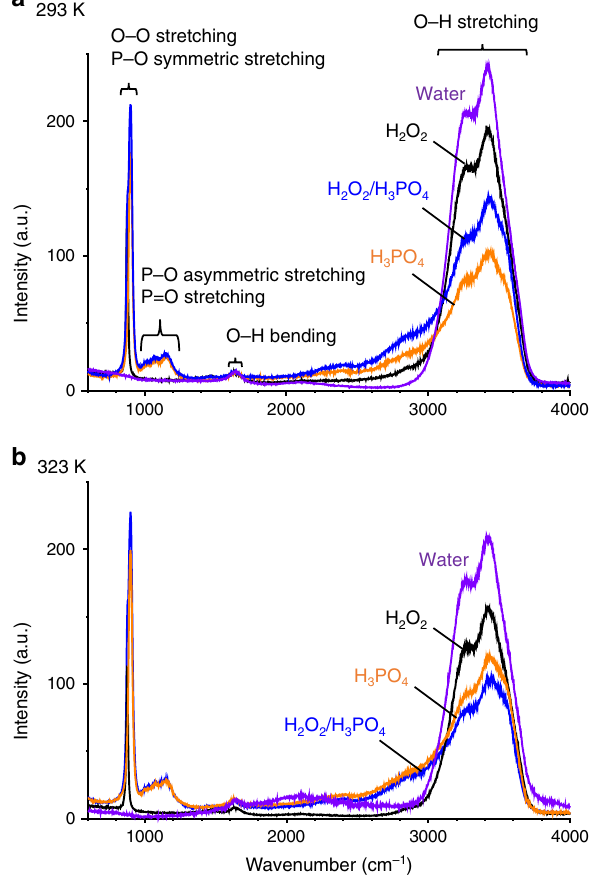
Fig. 4 Raman spectra (600 – 4000 cm − 1 region) of the respective solutions. a 293 K. b 323 K. The H 2 O 2 and H 3 PO 4 concentrations are 2 M and 4 M,